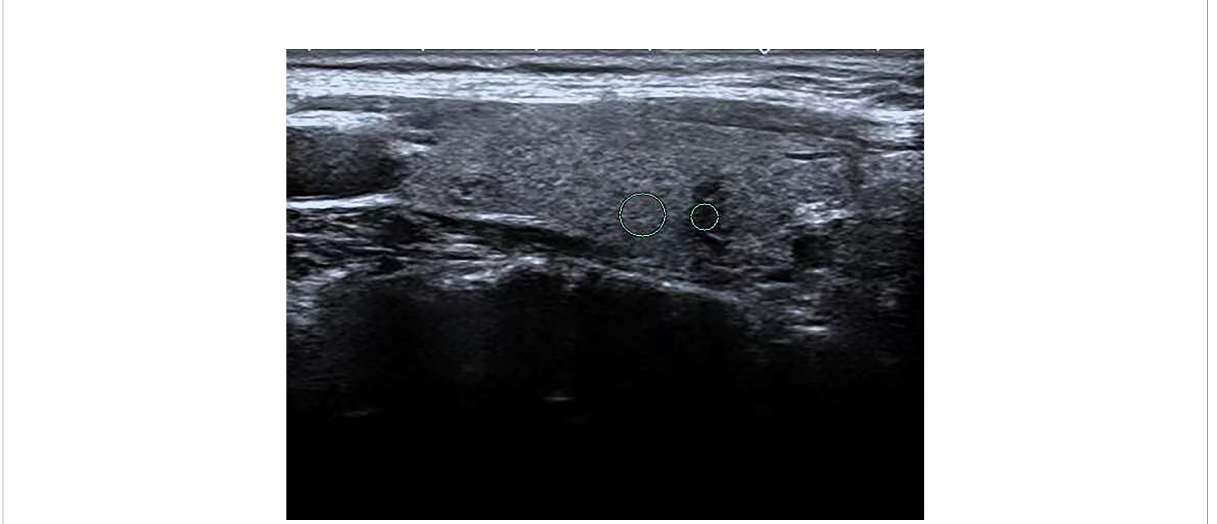
FIGURE 5 Female patient, 45 years old, 1-week case history of a thyroid nodule, pathology con fi rmed as a hyperplastic nodule with HT. TG-Ab = 115 kU/L, TPO-Ab< 28 kU/L, UGSR = 22.96/73.95 = 0.3105 (medical center